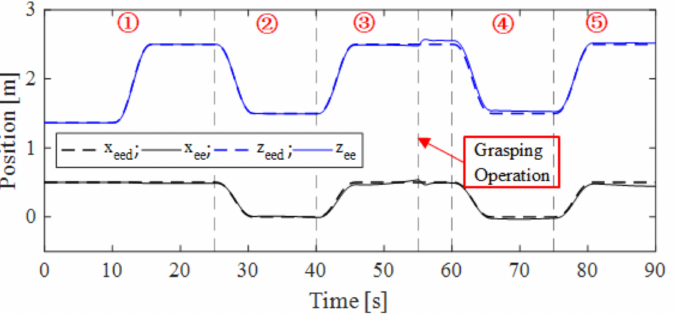
Figure 10. The desired and actual position of end effector with vehicle position control.